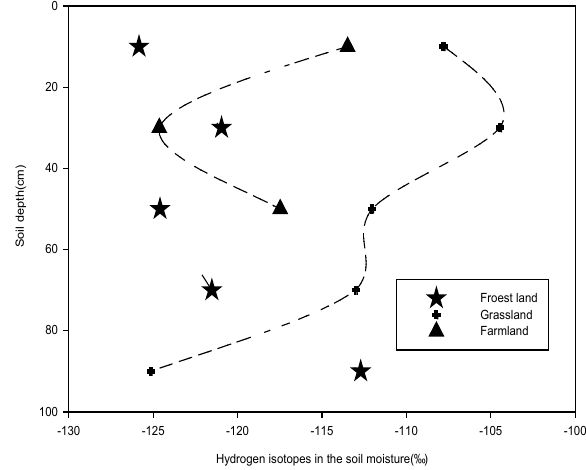
Figure 3: Vertical variations of hydrogen isotopes in the soil moisture under different land use types.